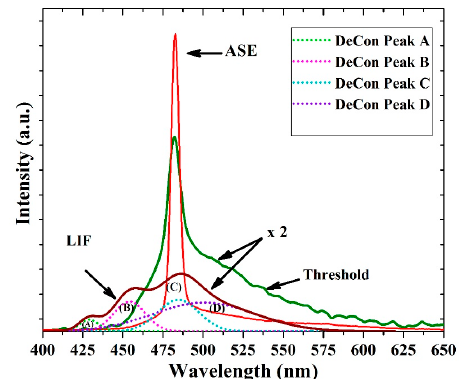
Figure 10. Amplified spontaneous emission (ASE), threshold, and laser-induced fluorescence (LIF) spectra of the CO film with a thickness of 380 nm and a concentration of 15 mg / mL. The Figure 10 also shows deconvolution (DeCon) of LIF spectra, where the light green (A), Pink (B), sky blue (C) and violet (D) bands are ascribed to V0, V1, V2 and dimer bands.